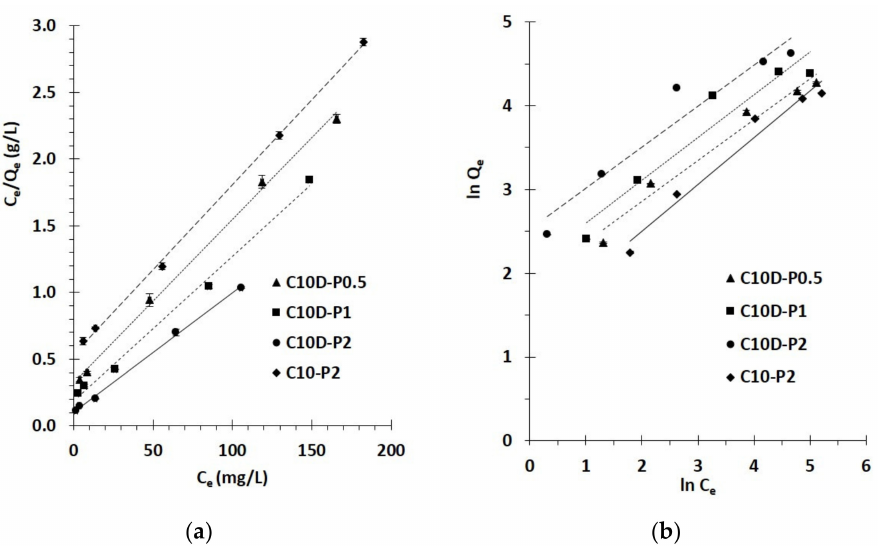
Figure 10. ( a ) Langmuir isotherm; ( b ) Freundlich isotherm of PQ adsorption (conditions: 2 g/L of